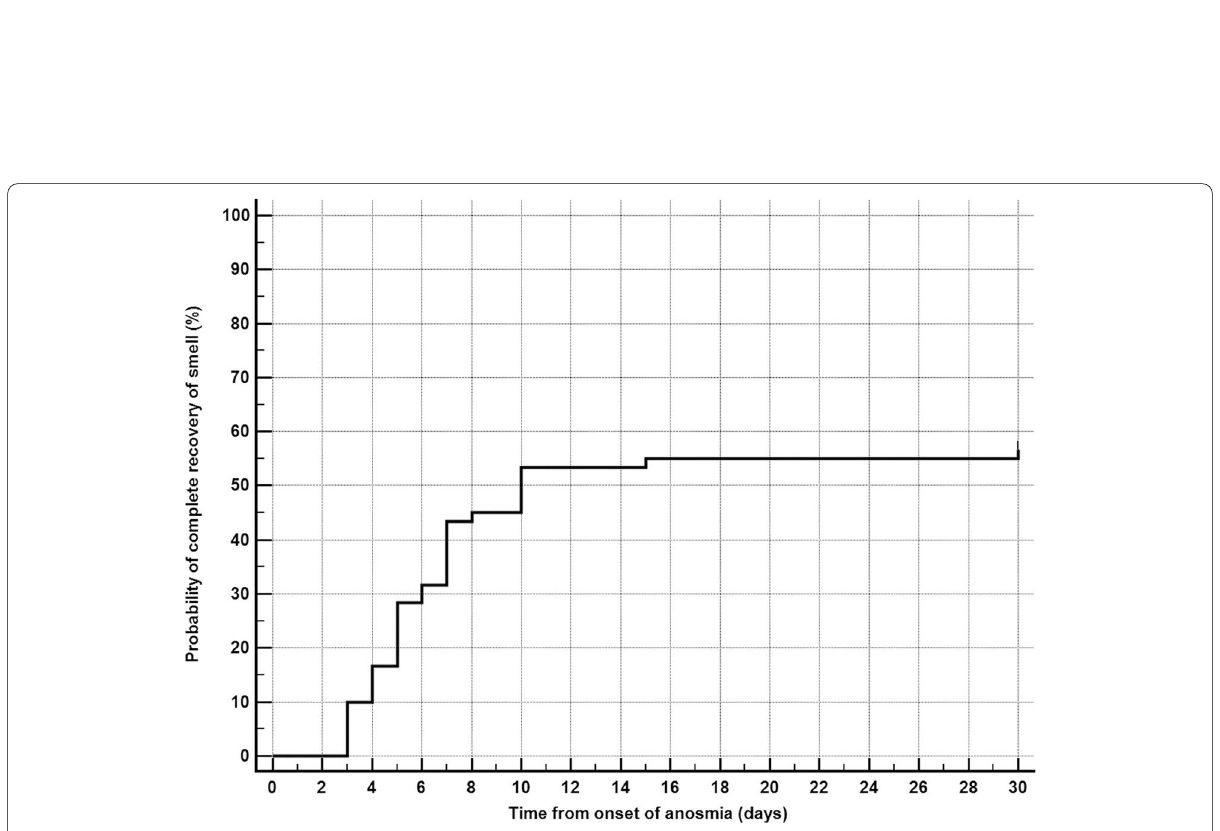
Fig. 3 Kaplan-Meier curve for time to complete recovery of smell. Median time to complete recovery